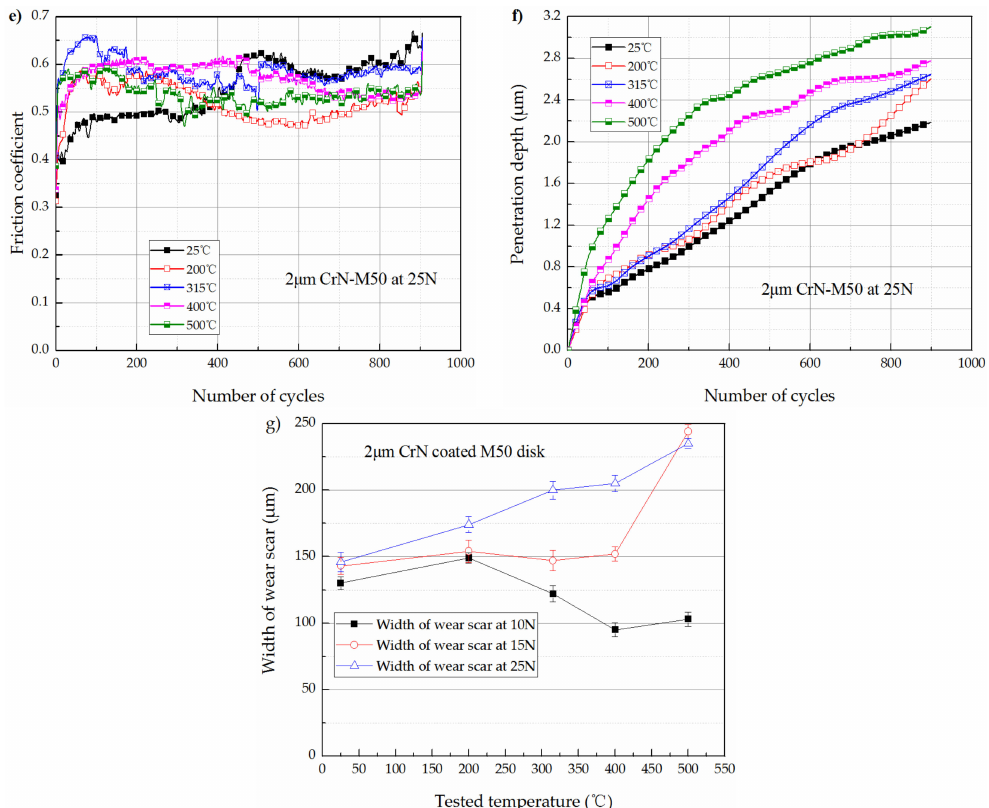
Figure 7. Friction coefficient curves and penetration depth during wear test of the 2 µ m CrN coated M50 disks: ( a ) variation of friction coefficient with temperatures under 10 N; ( b ) variation of penetration depth with temperatures under 10 N; ( c ) variation of friction coefficient with temperatures under 15 N; ( d ) variation of penetration depth with temperatures under 15 N; ( e ) variation of friction coefficient with temperatures under 25 N; ( f ) variation of penetration depth with temperatures under 25 N; and ( g ) variation of width of wear scars with